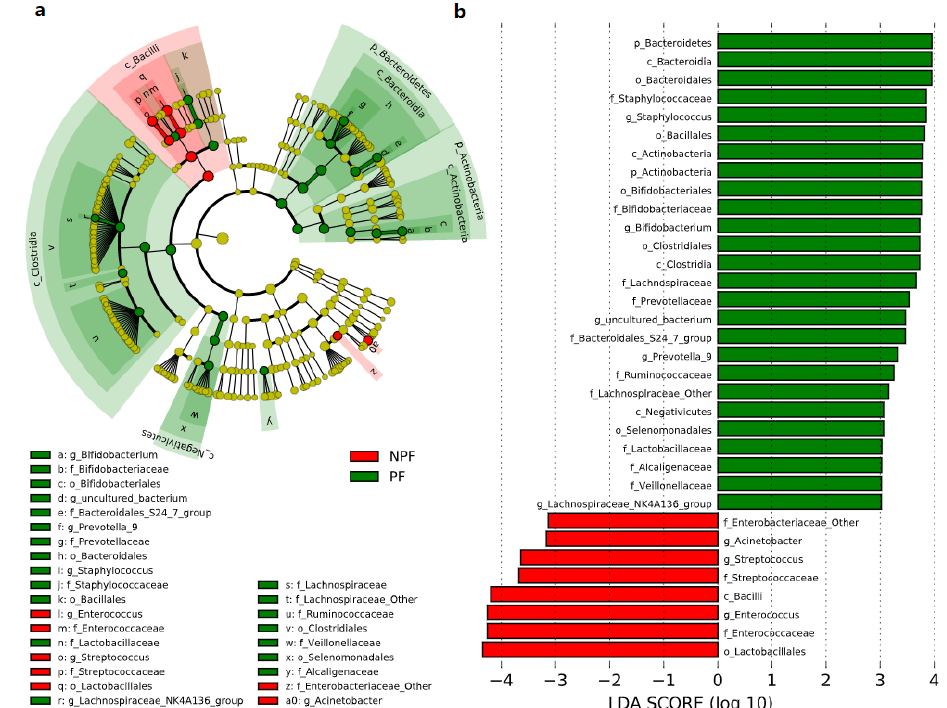
Figure 4. Differential bacterial taxa between the NPF and PF groups at week 1 revealed by LDA cladogram ( a ) and ranking ( b ). Only taxa with an LDA score threshold more than 3 are shown. LEfSe, linear discriminant analysis of effect size; LDA, linear discriminant analysis; PF, probiotics formula; NPF, non-probiotics formula; p, phylum; c, class; f, family; o, order; g, genus.